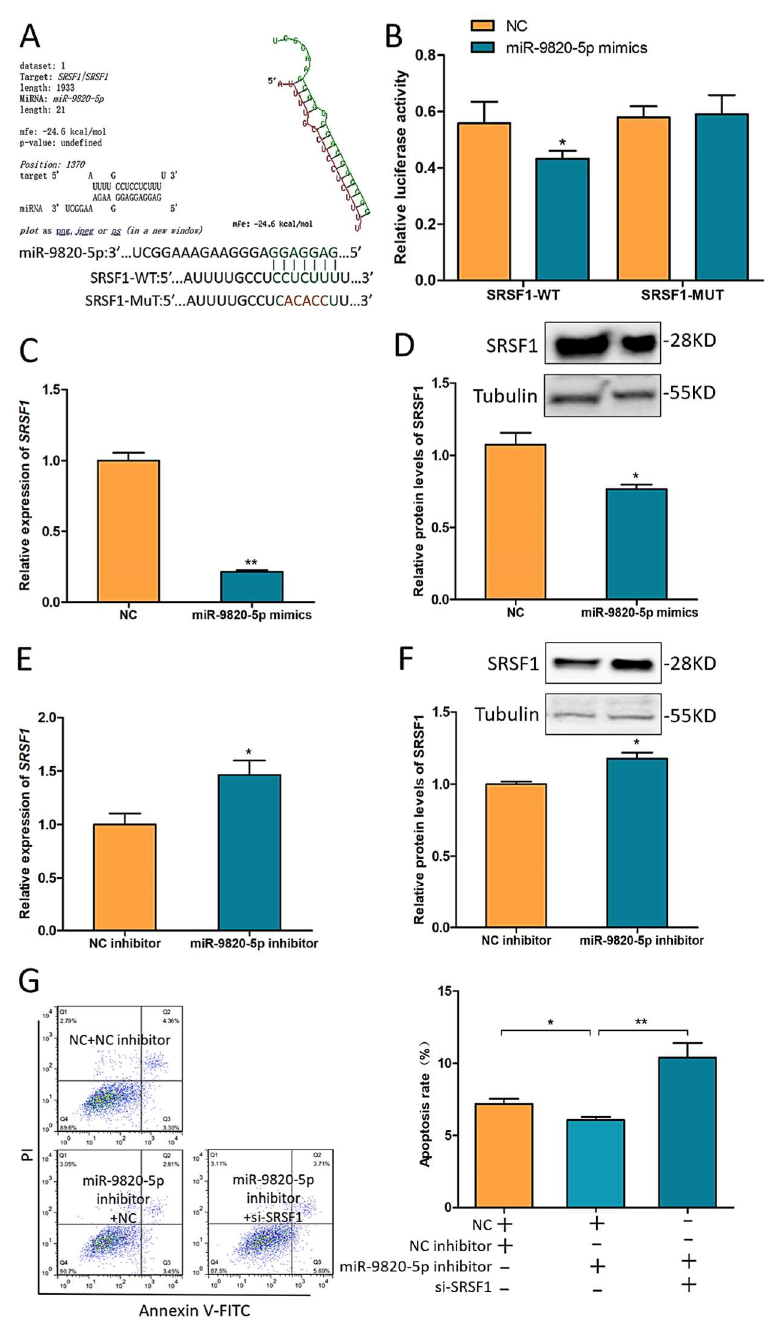
Figure 5. miR-9820-5p promotes pGCs apoptosis by targeting SRSF1 . ( A,B ) The binding of miR−9820−5p and SRSF1−WT was predicted by RNAhybrid and verified by dual−luciferase activity 5p and SRSF1-WT was predicted by RNAhybrid and verified by dual-luciferase activity analysis. analysis. ( C,D ) SRSF1 mRNA and protein levels after transfection of miR−9820−5p mimics. ( E,F ) ( C , D ) SRSF1 mRNA and protein levels after transfection of miR-9820-5p mimics. ( E , F ) SRSF1 mRNA SRSF1 mRNA and protein levels after transfection of miR−9820−5p inhibitors. ( G ) The shift of GC and protein levels after transfection of miR-9820-5p inhibitors. ( G ) The shift of GC apoptosis rates apoptosis rates after co−transfection of miR−9820−5p inhibitors and si−SRSF1 detected by flow cy- after co-transfection of miR-9820-5p inhibitors and si-SRSF1 detected by flow cytometry. Data are tometry. Data are expressed as the mean ± SEM of three experiments; * p < 0.05, ** p < 0.01. expressed as the mean ± SEM of three experiments; * p < 0.05, ** p <